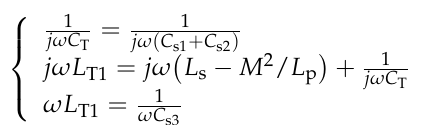
where ω = 2 πf , f = 1/ T , f is the working frequency of the system, T is the working period of